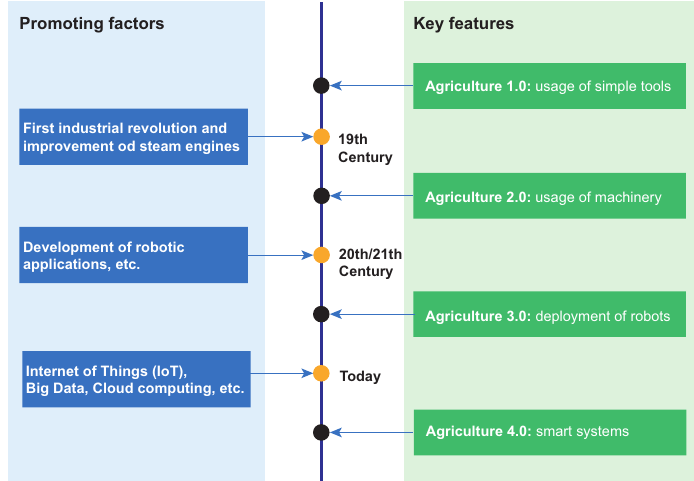
Figure 1. Evolution process from Agriculture 1.0 to Agriculture